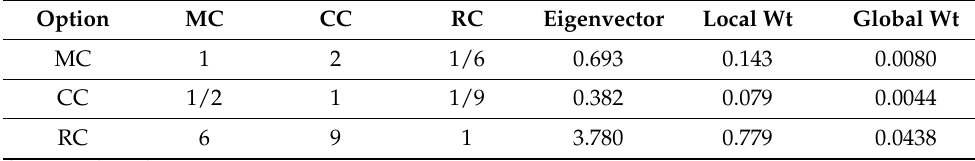
Table A17. Comparison of alternatives matrix for subcriterion EN1.